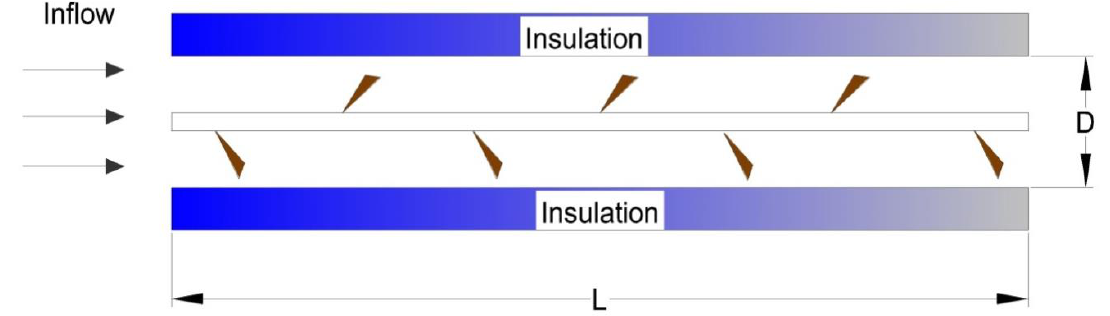
Figure 4. Schematic of the conical strip insert with a forward (FWD) arrangement in the test